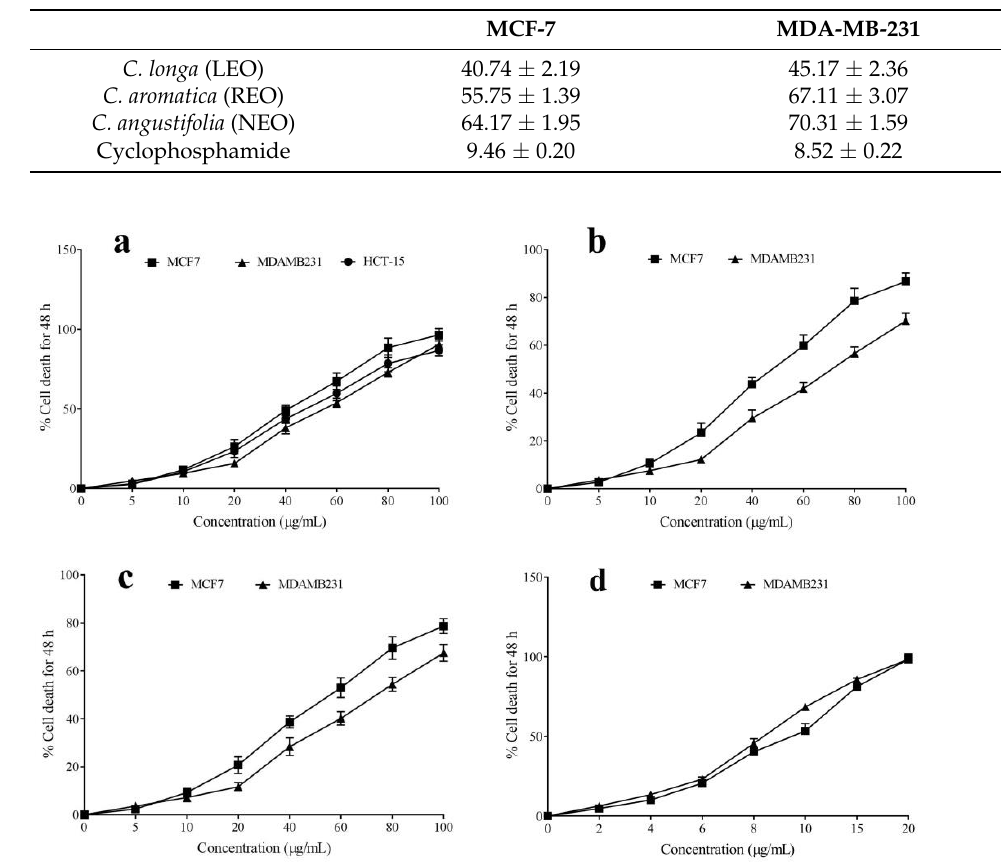
Figure 2. Cytotoxic activity of leaf essential oils extracted from Curcuma longa ( a ), Curcuma aromatica , ( b ) Curcuma angustifolia ( c ), and cyclophosphamide ( d ) against breast cancer cell lines—MCF7 (ER positive) and MDA-MB-231 (triple negative) .